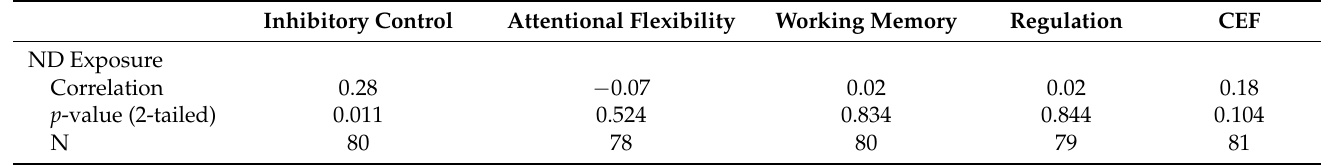
Table 3. Bivariate correlations between non-dominant language exposure and EEFQ